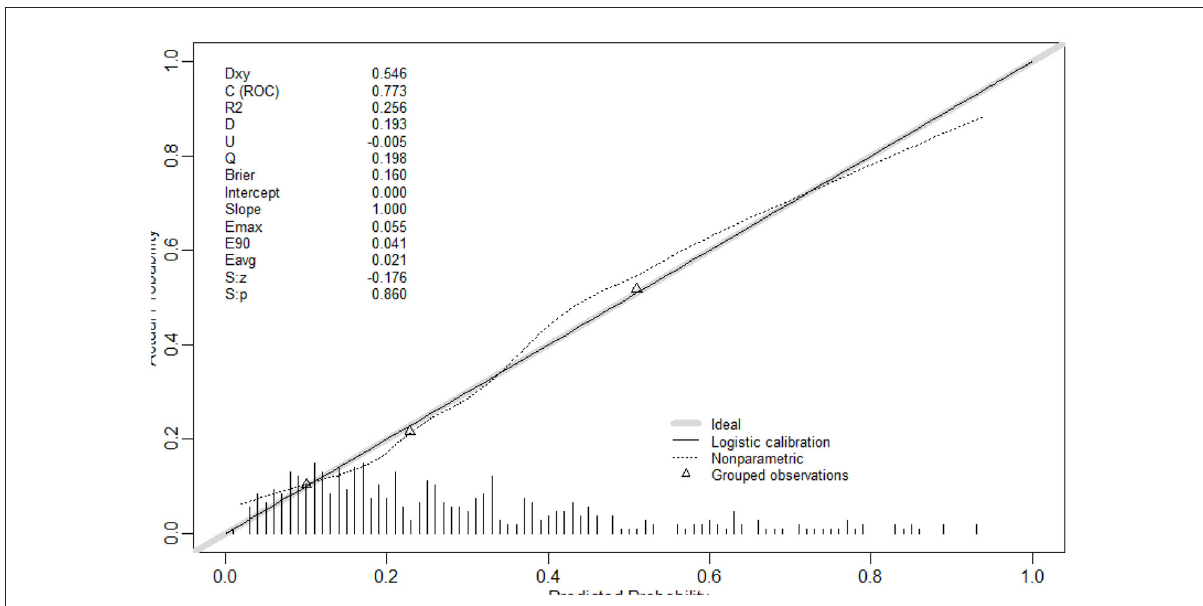
FIGURE4 The calibration curve indicated good consistency between the actual diagnosed therapeutic effectiveness and the predicted